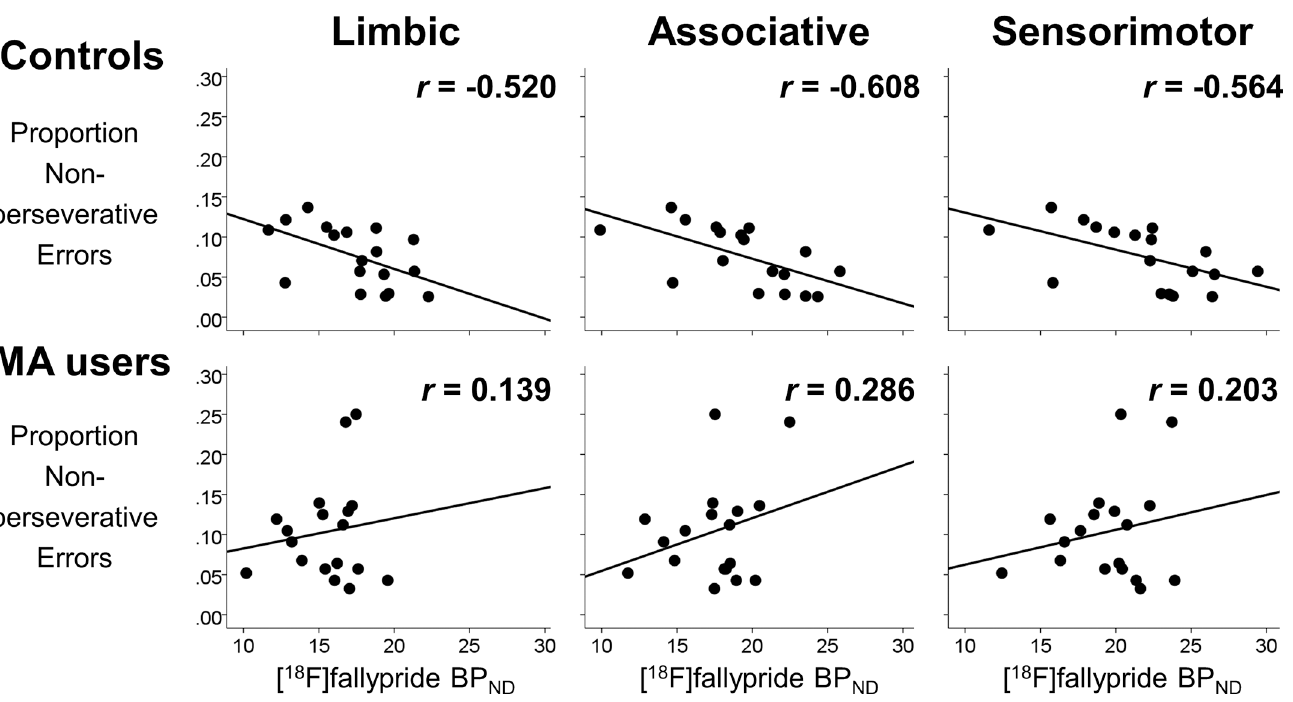
Fig 2. Relationships between D 2 /D 3 receptor availability in striatal subregions and executive function measures. Regression lines illustrate correlations between striatal dopamine D 2 /D 3 receptor availability (indexed by [ 18 F]fallypride BP ND ) and proportions of trials registered as non-perseverative and perseverative errors in the striatal functional subdivisions of methamphetamine (MA) users (bottom row) and non-user controls (top row). Pearson product-moment correlation coefficients are shown ( r values).